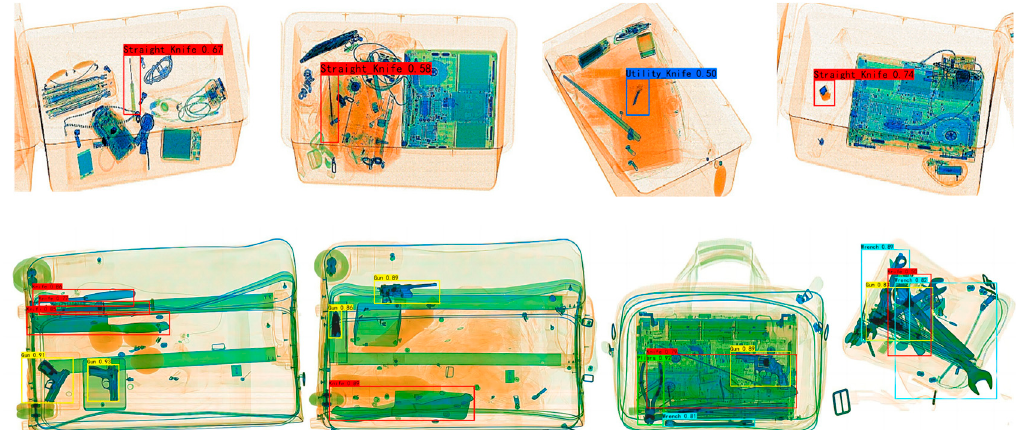
Figure 11. Detection performance in OPIXray and SIXray. The first line is the detection performance of OPIXray and the second line is that of the SIXray.